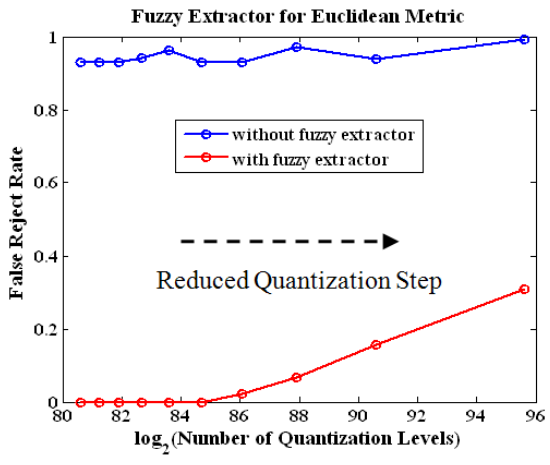
Figure 7. Performance of Euclidean metric fuzzy